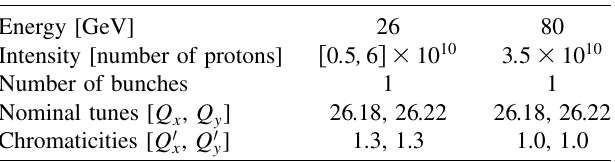
TABLE I. Measured beam conditions for the experiments in 2002.